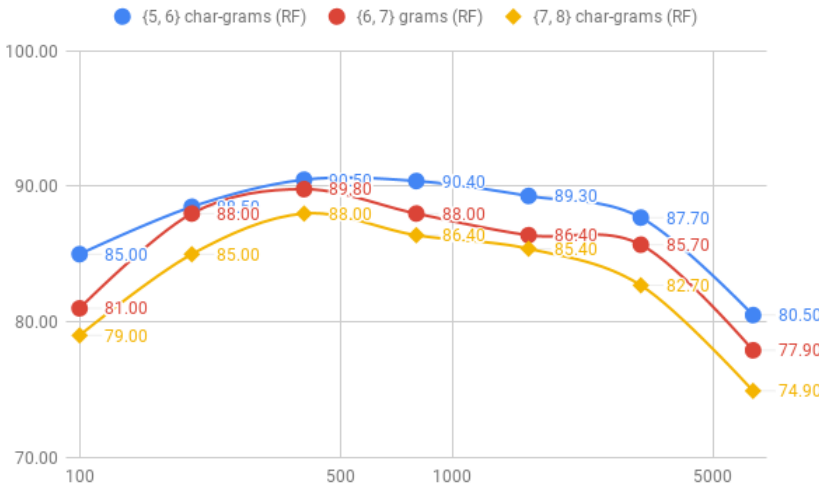
Figure 10. Comparison of the accuracy between {5, 6}, {6, 7}, {7, 8} char-grams for the RF classifier.